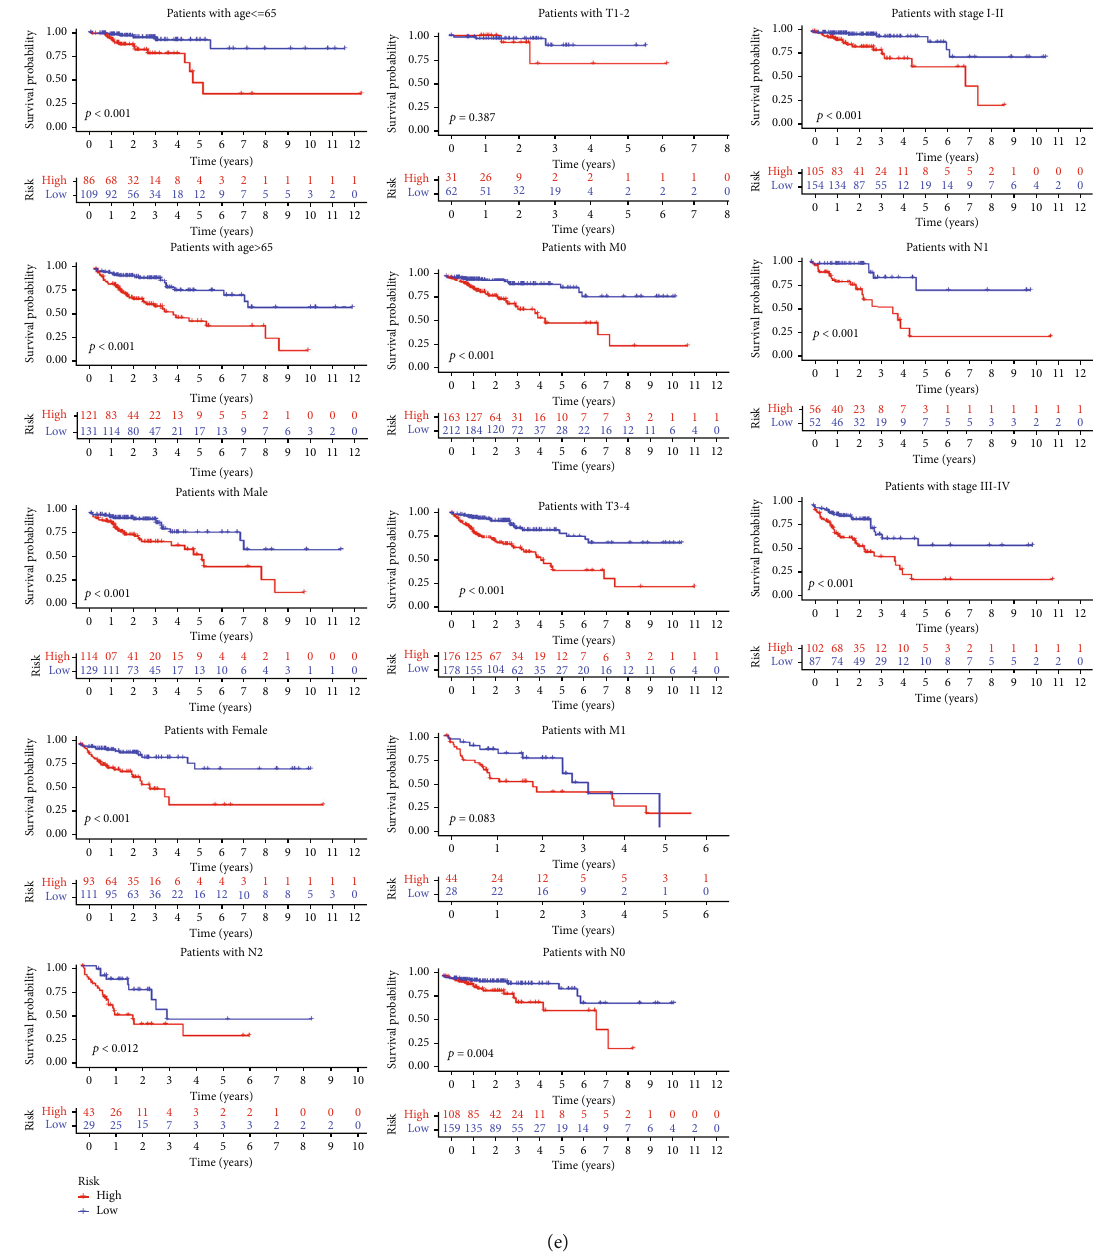
Figure 5: Clinical applicability of prognostic signature. (a, b) Univariate and multivariate Cox regression analysis of the correlation between the risk scores and clinicopathological features. (c) ROC curve analyses of the risk scores and clinicopathological features. (d) The heat map and clinicopathological factors of high- and low-risk subgroups. ∗ P < 0 : 05 , ∗∗ P < 0 : 01 , ∗∗∗ P < 0 : 001 . (e) The Kaplan – Meier survival analyses of prognostic signature in di ff erent clinical subgroups based on age, gender, stage, grade, and TMN stage with the log-rank